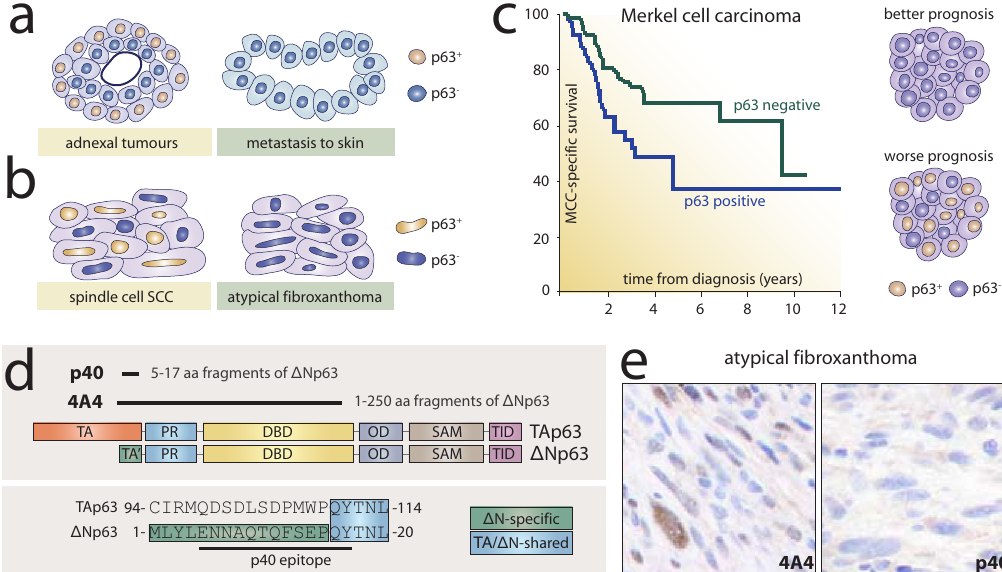
Figure 3. Diagnostic and prognostic value of p63 in skin cancer. p63 can be used in diagnostics to distinguish adnexal tumours from metastases to skin ( a ) as well as spindle cell squamous cell carcinoma from atypical fibroxanthoma ( b ); ( c ) In Merkel cell carcinoma, p63 expression is correlated with poor prognosis. The Kaplan–Meier plot shows the MCC-specific survival of patients with p63-positive and p63-negative tumours (modified from [117]); ( d ) 4A4 antibody is a pan-p63 antibody that recognises the DNA-binding domain of all isoforms of p63. By contrast, the p40 antibody recognises a specific portion of the N-terminus of ∆ Np63 isoforms; ( e ) p40 is superior to pan-p63 4A4 in the diagnosis of atypical fibroxanthoma (modified from